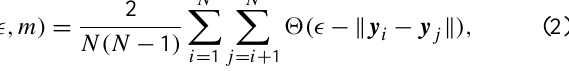
are important. We have used the method of autocorrelation 205